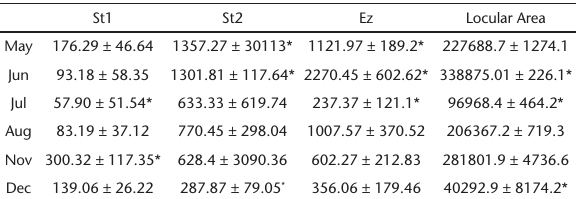
Table 1. Monthly values (mean and standard error) for density of primary spermatids (St1), secondary spermatids (St2), sperm (Ez) (mm 2 ) and locular area (µm 2 ) of the testes of Leptodactylus mac- rosternum species collected in the HFOB area, municipality of Cuité, state of Paraíba, Brazil, in the period from May to December 2013. * Significant differences (p < 0.05, Kruskal-Wallis).